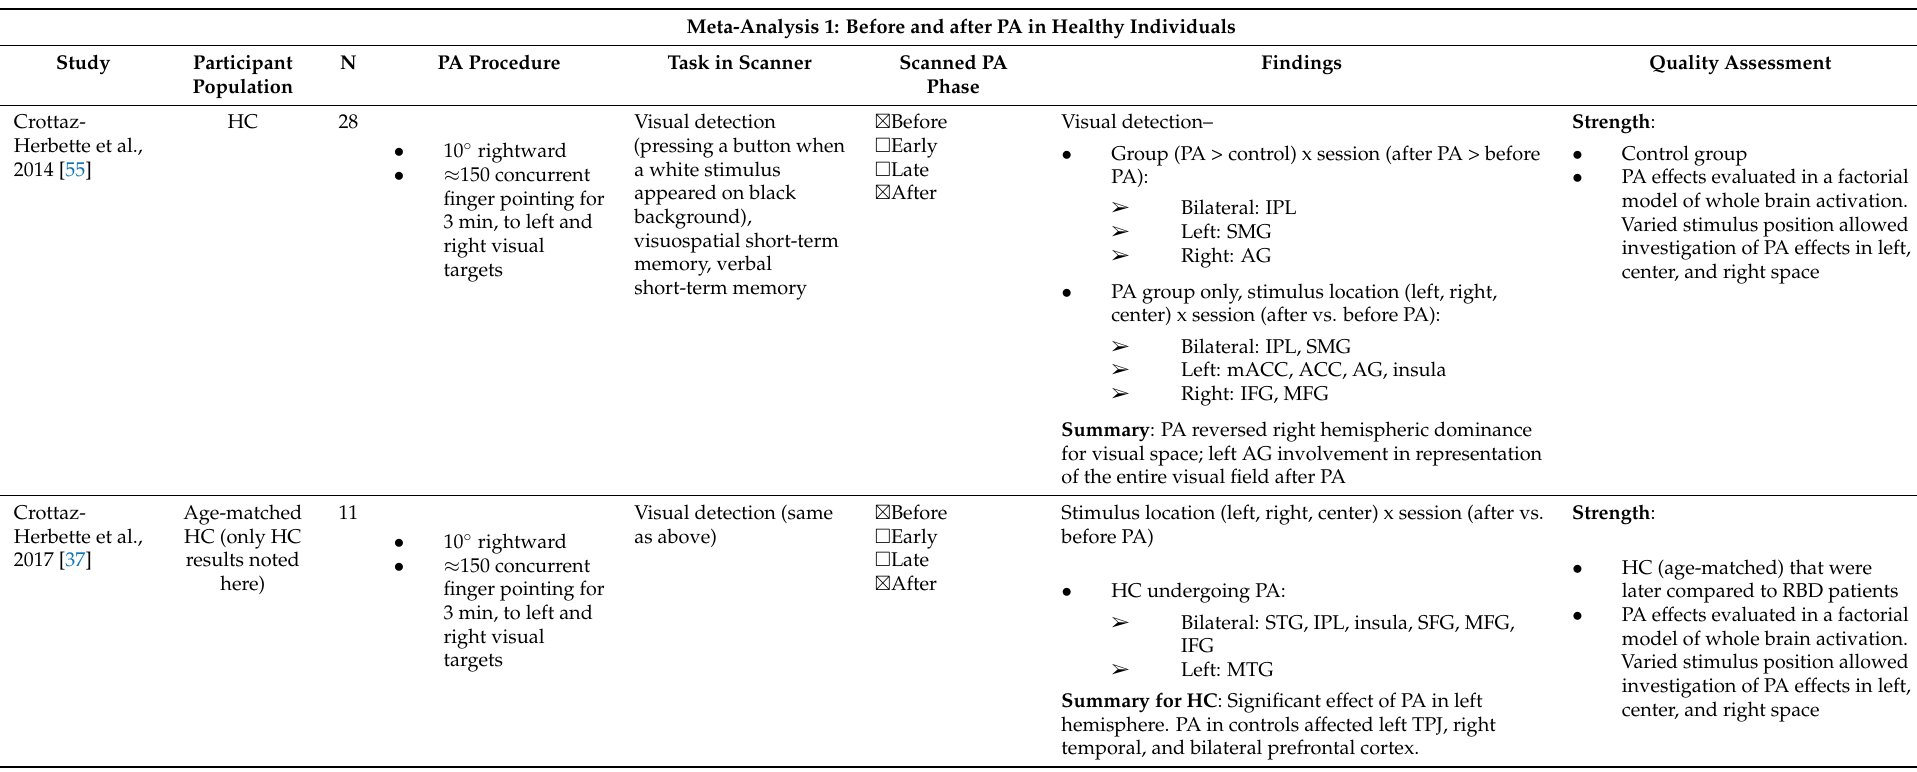
Table 1. Task-specific fMRI studies of prism adaptation (PA). Meta-Analysis 1 includes five studies that scanned healthy individuals before and after PA who performed tasks different from the task they performed during PA. Meta-Analysis 2 includes three studies that scanned individuals with right brain damage (RBD) due to stroke before and after PA who performed the same or different tasks from the task they performed during PA. Meta-Analysis 3 includes four studies that scanned healthy individuals during